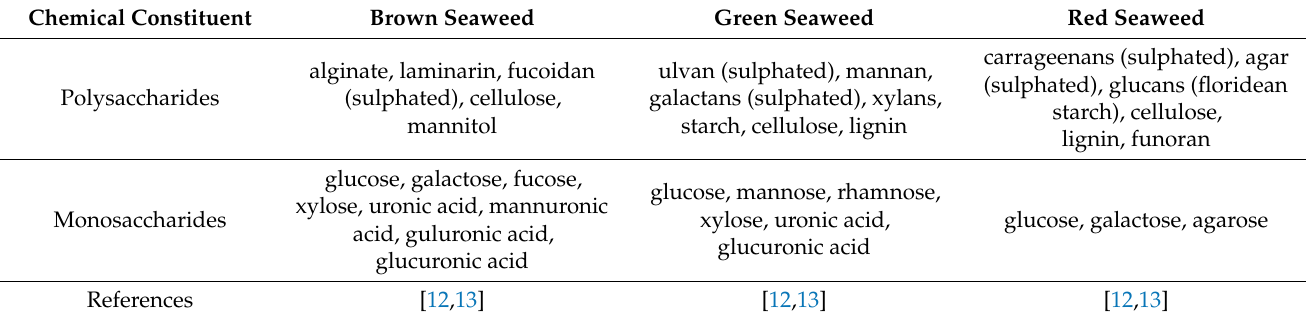
Table 1. Polysaccharides and monosaccharides constituent of brown, green, and red seaweeds. Chemical Constituent Brown Seaweed Green Seaweed Red Seaweed carrageenans (sulphated), agar alginate, laminarin, fucoidan ulvan (sulphated), mannan, (sulphated), glucans (floridean Polysaccharides (sulphated), cellulose, galactans (sulphated), xylans, starch), cellulose, mannitol starch, cellulose, lignin lignin, funoran glucose, galactose, fucose, glucose, mannose, rhamnose, xylose, uronic acid, mannuronic Monosaccharides xylose, uronic acid, glucose, galactose, acid, guluronic acid, glucuronic acid glucuronic acid